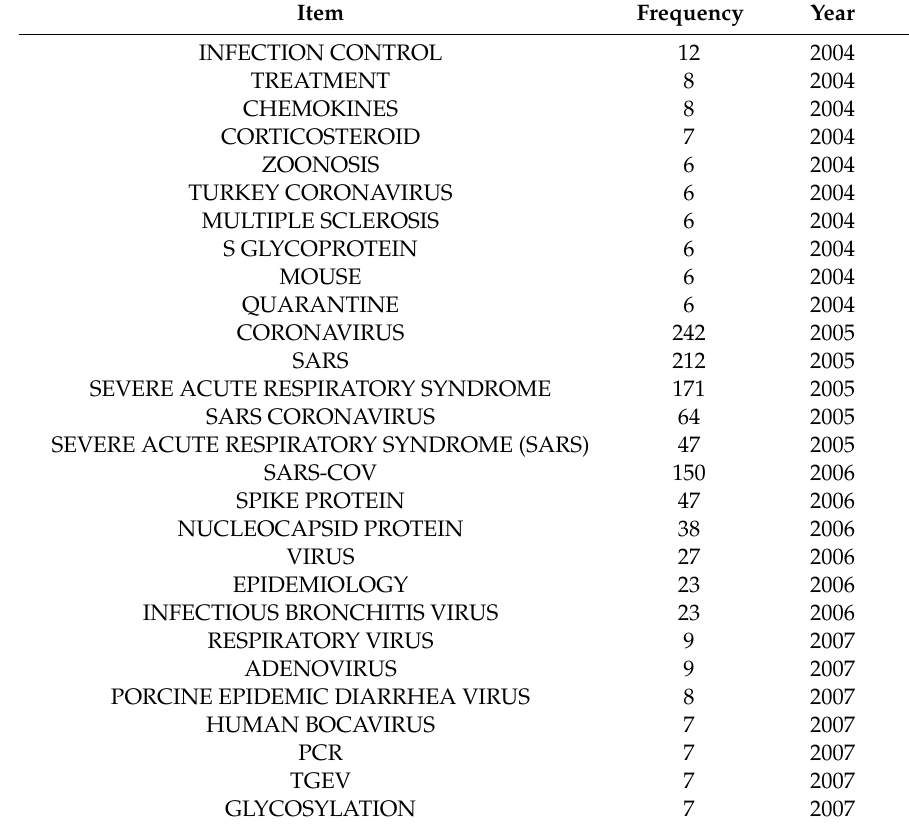
Table 3. Items and frequency of hot keywords during 2004–2007.